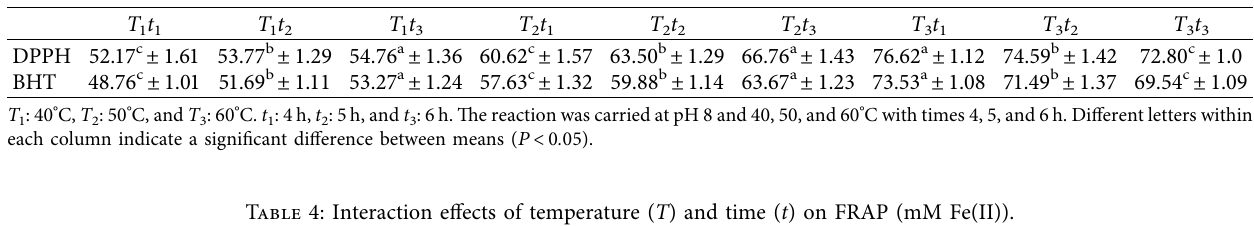
Table 3: Interaction efects of temperature ( T ) and time ( t ) on DPPH (%).